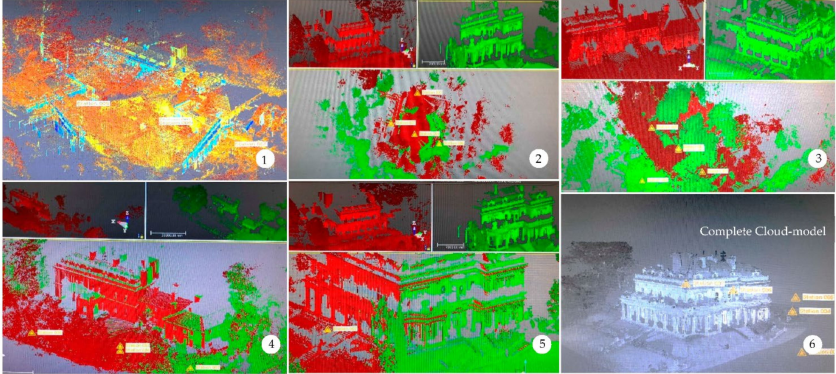
Figure 9. Point cloud registration stages: (1) automatic registration; (2, 3, 4, 5, 6) manual registration. Manual cloud registration was conducted on all the cloud stations and, as a result, a coherent model with complete matching stations and low error level (less <10 mm) was created. The resulting cloud model represents a collection of separated station scans for the Headington Hill Building, as illustrated in Figure